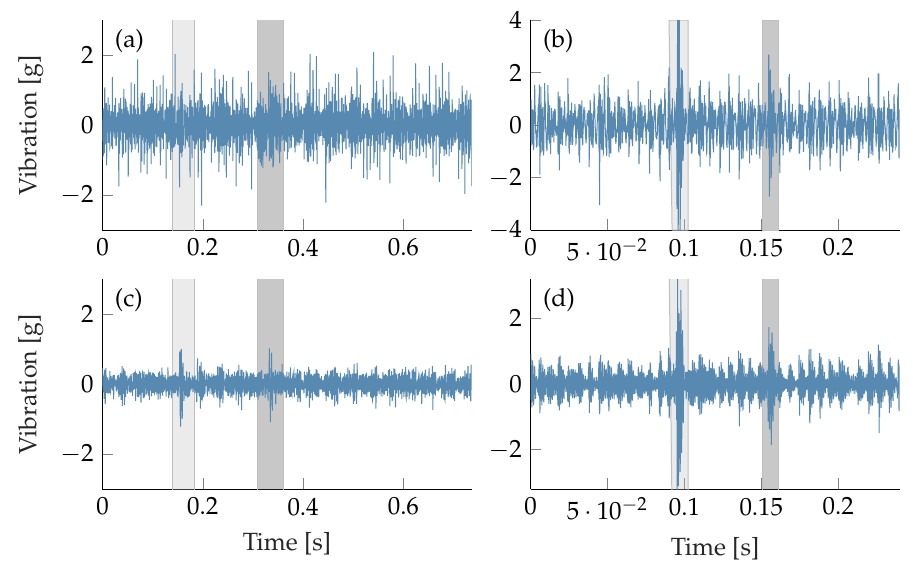
Figure 17. Results of multiband FIR filtering for the gearbox with damage on gear z 1 ( a ) unfiltered— ( c ) filtered and for the gearbox with damage on gear z 3 ( b ) unfiltered—( d ) filtered. The rotational speed is 220rpm and the torque is